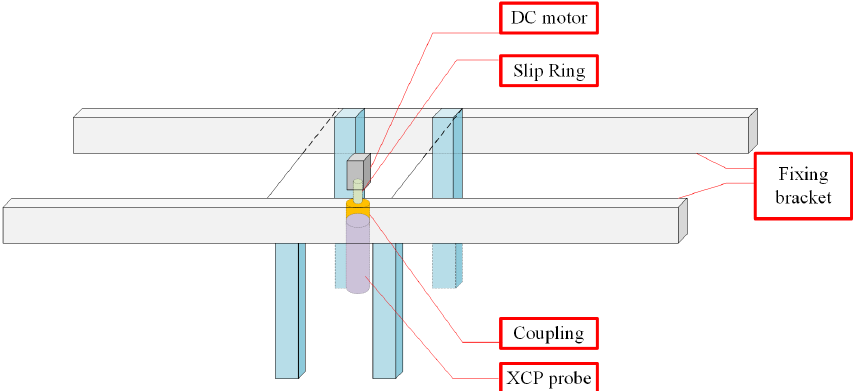
Figure 13. Schematic diagram of rotating structure